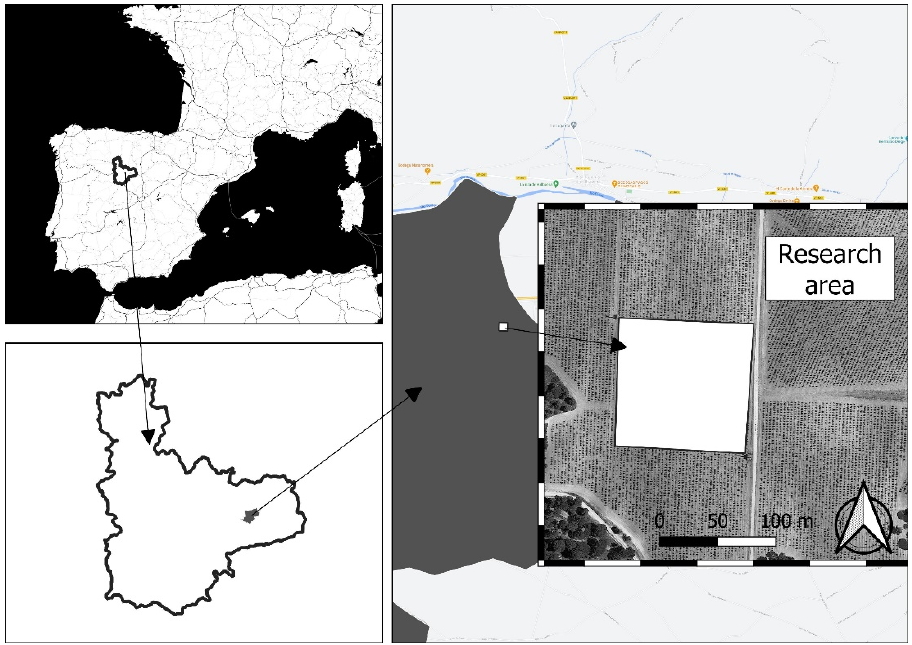
Figure 9. Location map of the research area within the municipality of Valbuena de Duero in grey, and this within the Valladolid province surrounded by the solid line in Spain.